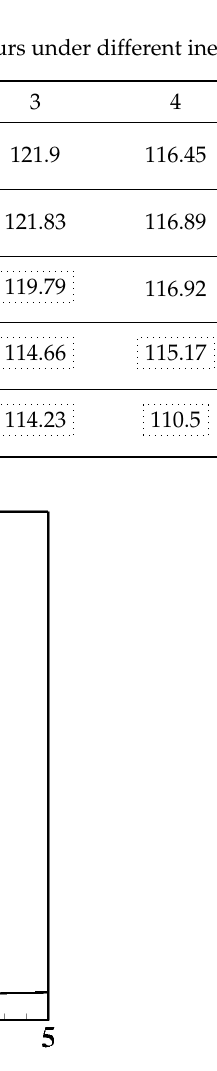
Table 2. The critical dynamic pressure when bifurcation occurs under different inertial resistances.